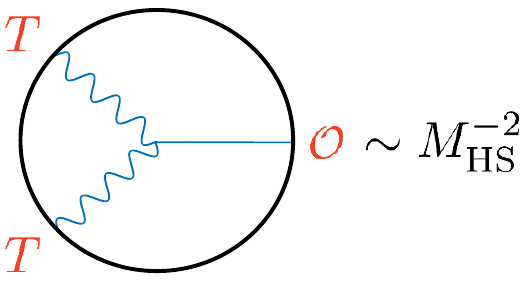
Figure 1 . In AdS, the cubic coupling of a scalar to two gravitons is suppressed as M (cid:0) 2 M HS (cid:24) (cid:1) gap is the mass scale of higher spin